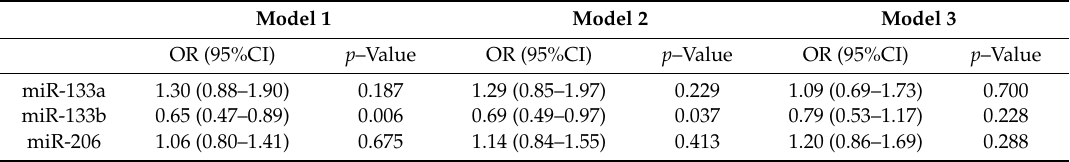
Table 2. E ff ect of miR-133a, miR-133b, and miR-206 on sarcopenia according to di ff erent logistic regression